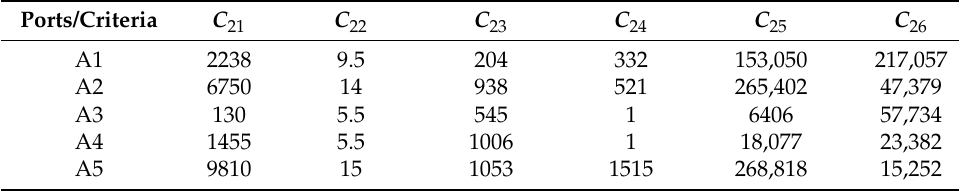
Table 5. Decision matrix for environmental criteria.